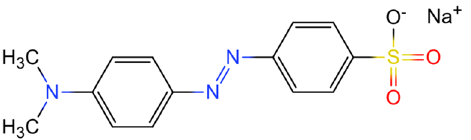
Figure 1. Schematic diagram of molecular structural formula of methyl orange.